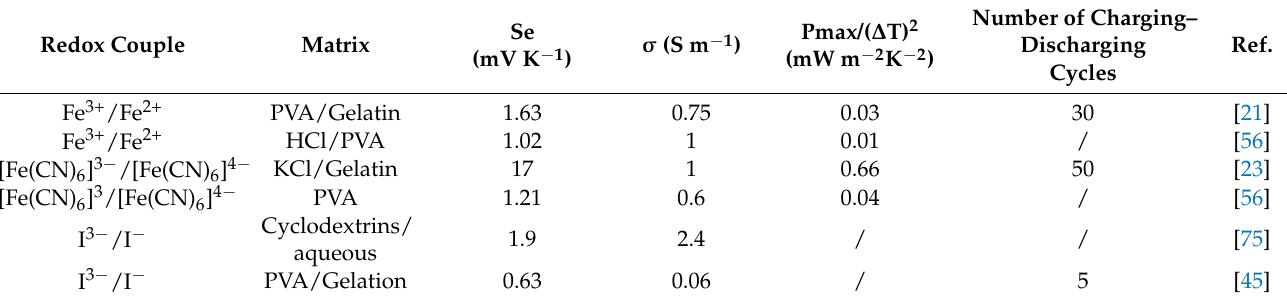
Table 1. Comparison of the Seebeck coefficient, electrical conductivity, power density, and number of charge–discharge